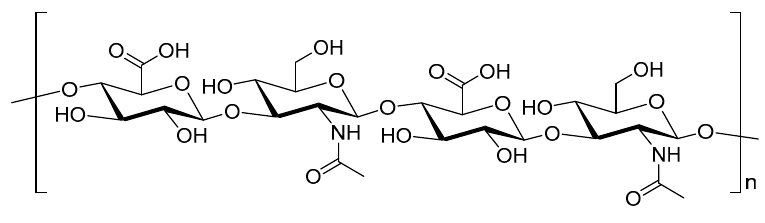
Figure 6. The chemical structure of hyaluronic acid.